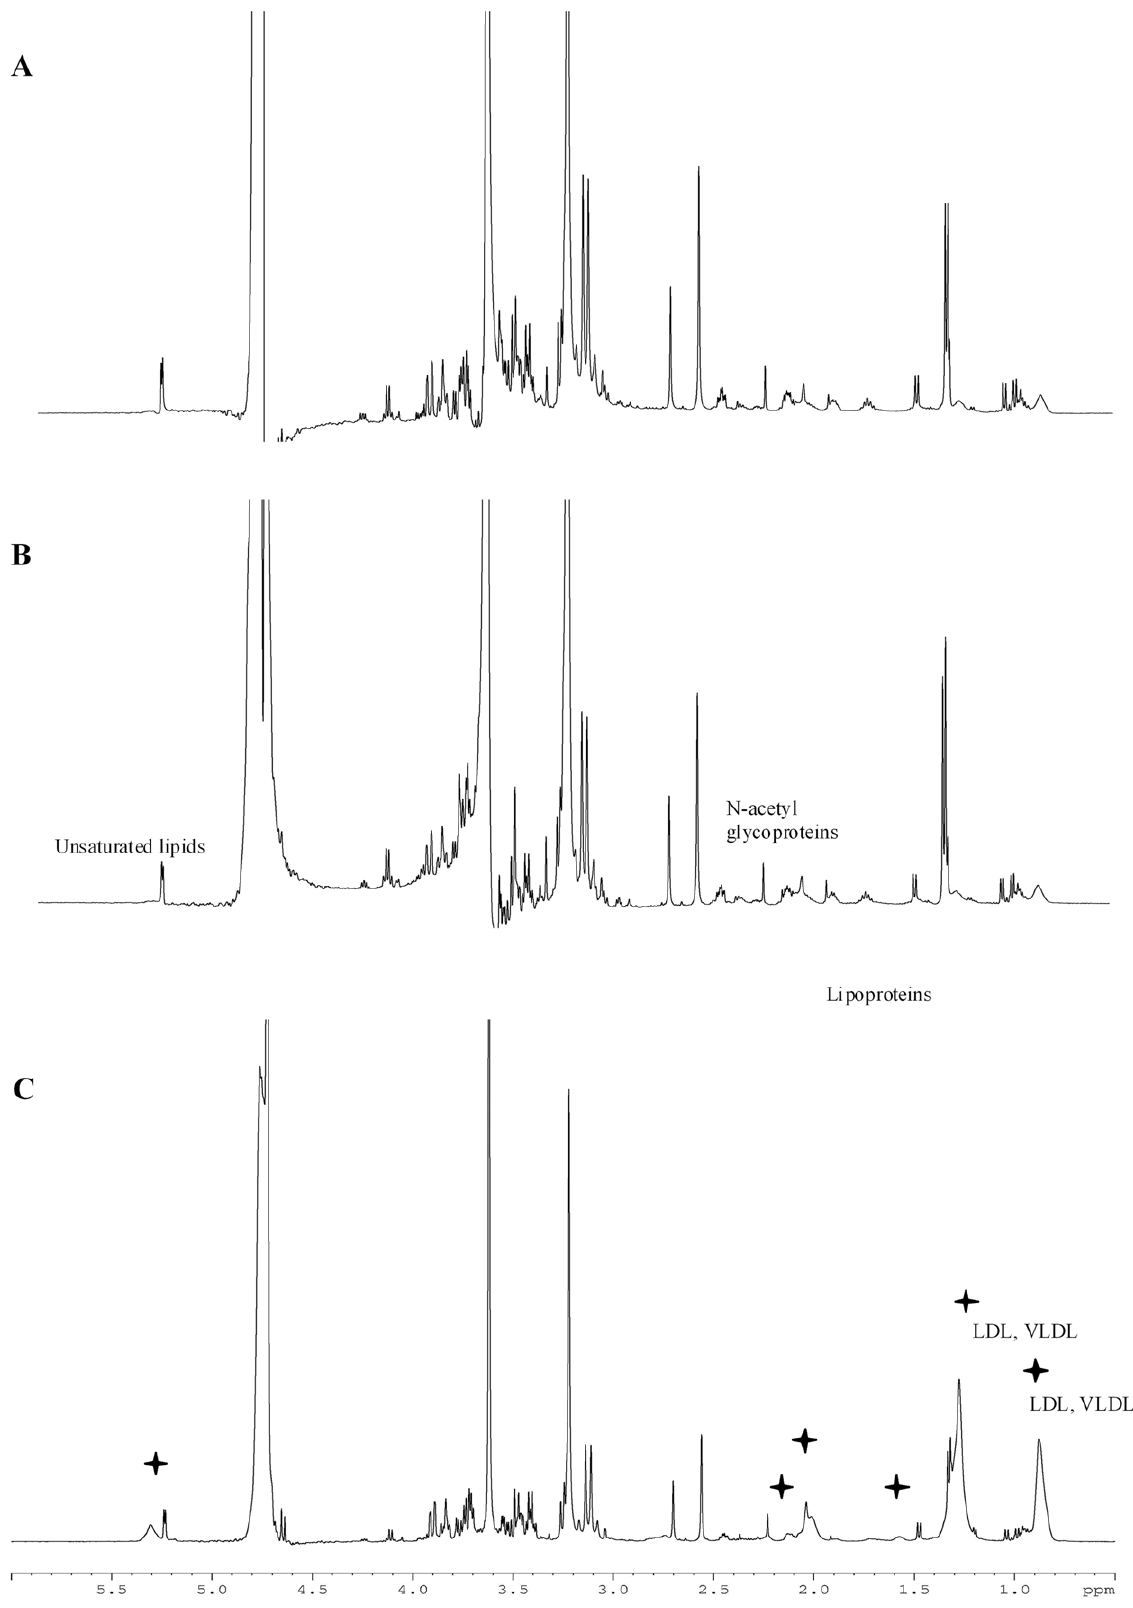
Figure 3. 500 MHz 1H NMR CPMG spectra of blood plasma samples from VLBW deliveries. (A) Arterial cord blood, (B) Venous cord blood (C) Maternal blood. The same spectral profile was obtained for arterial and venous blood plasma, whereas the spectrum of maternal blood plasma was different. The differences are marked by + . doi:10.1371/journal.pone.0029947.g003 PLoS ONE |